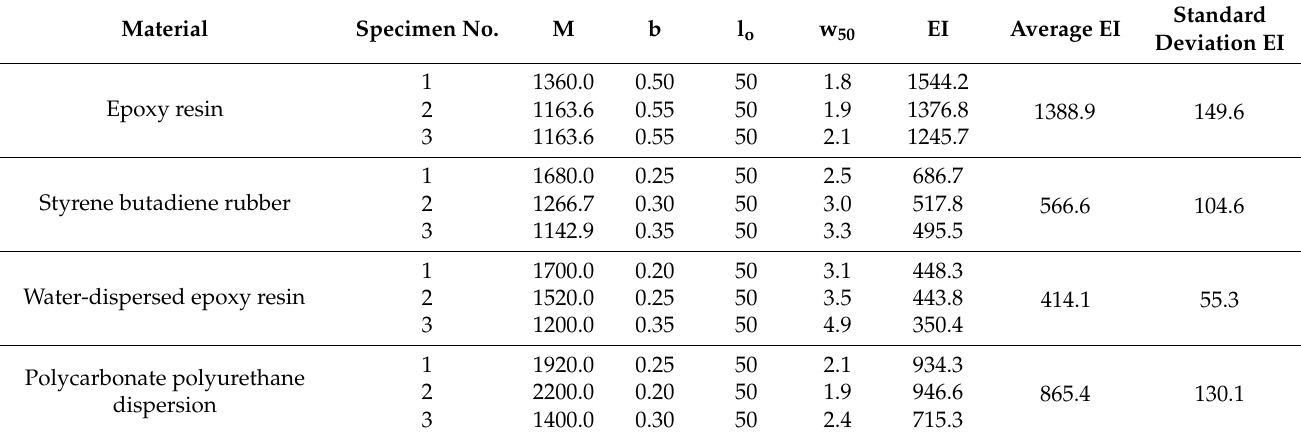
Table A1. Measured and calculated data for the cantilever